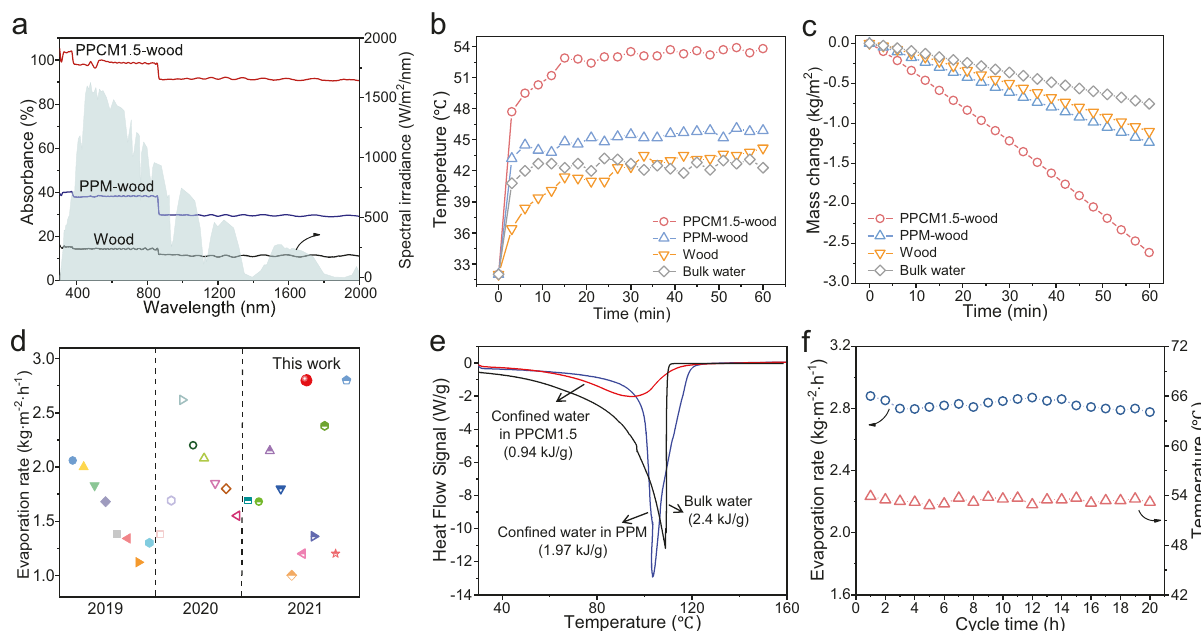
Fig. 6 Photothermal evaporation performance of PPCM1.5. a UV-vis-NIR absorption spectra of PPCM1.5-wood, PPM-wood, and wood. b Surface temperature and ( c ) evaporation rate of PPCM1.5-wood, PPM-wood, wood and bulk water under 1 kW/m 2 irradiation. d Comparison of the evaporation rate of PPCM1.5-wood with some previously reported photothermal materials. e DSC curves of con fi ned water in PPCM1.5 and PPM, compared to